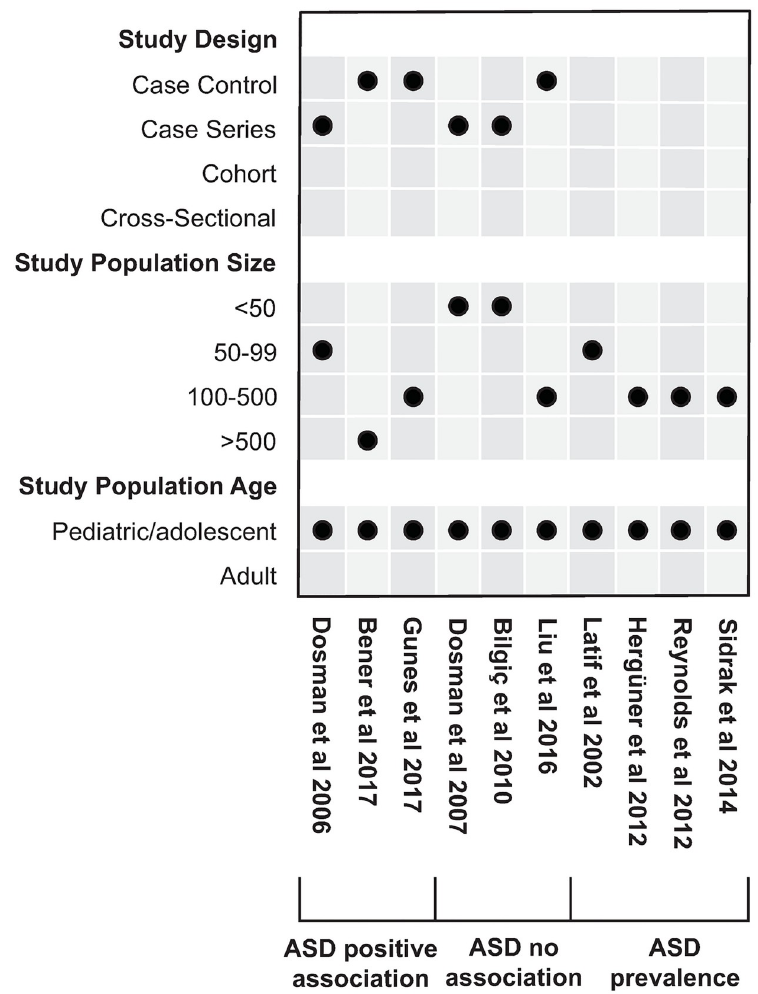
Fig 3. Overview of ASD association studies. Pediatric/adolescent studies: Age 19 years or less; adult studies: Age 19 years or greater.